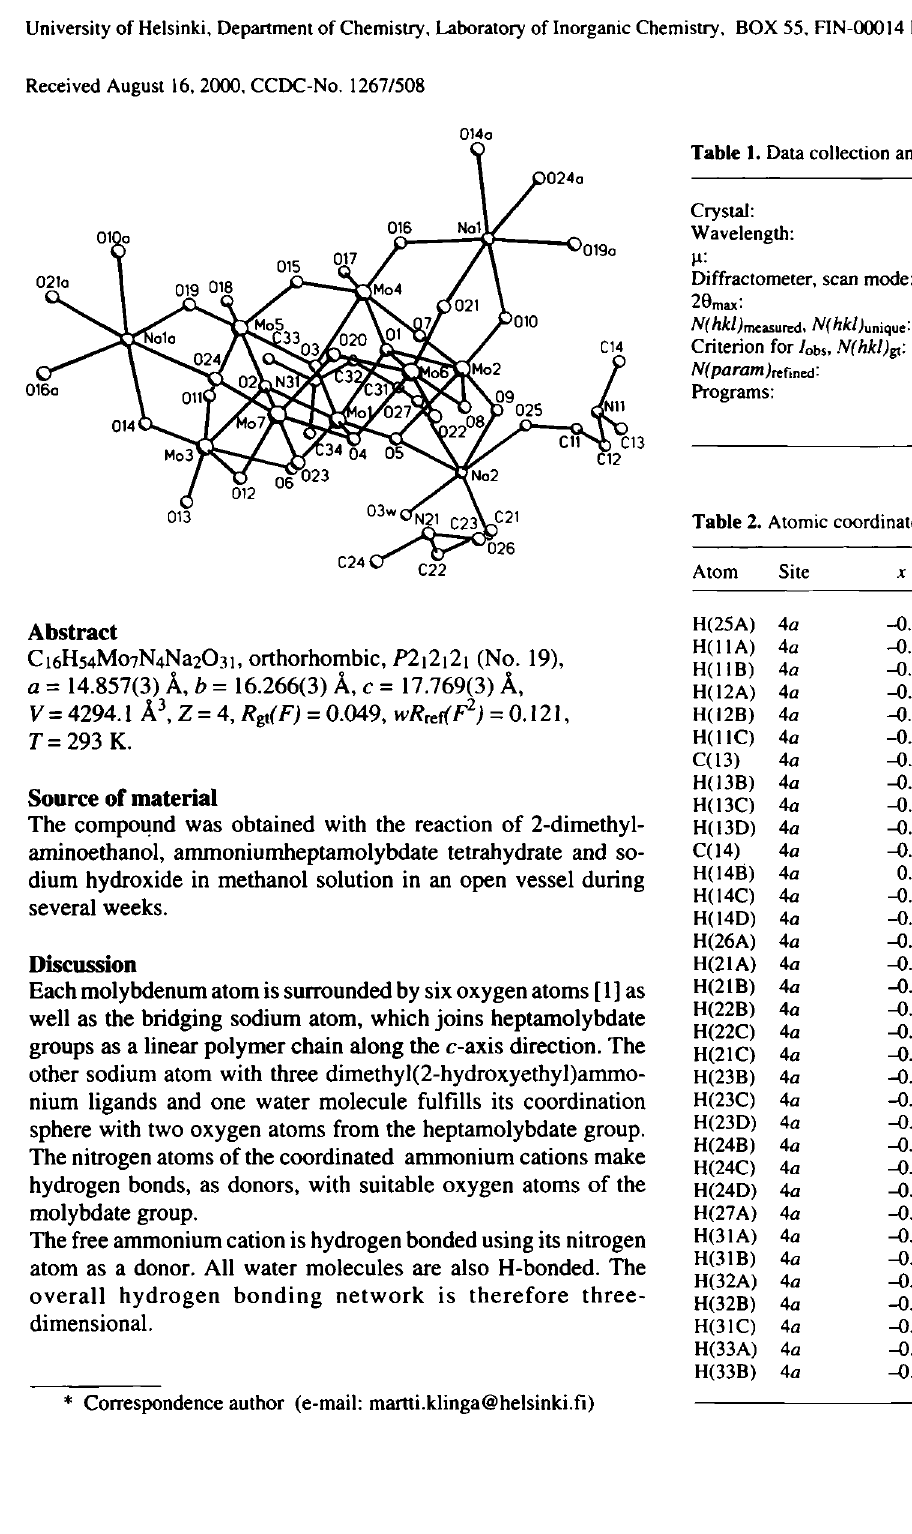
Table 2. Atomic coordinates and displacement parameters (in Ä 2